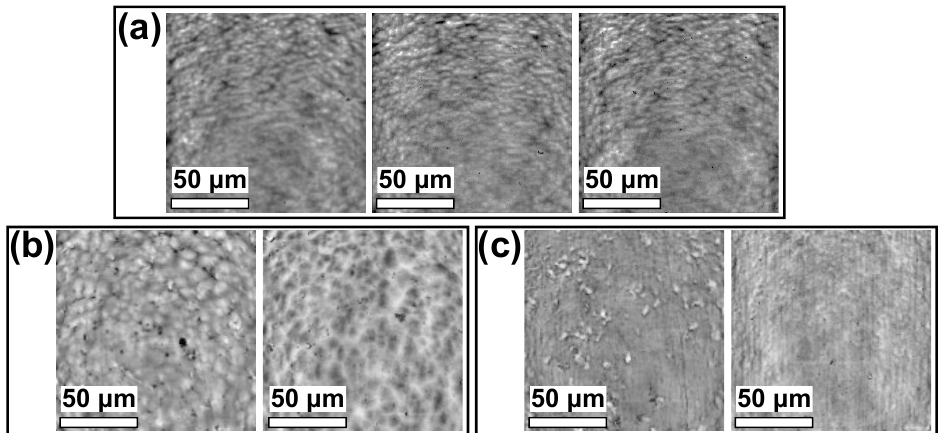
Figure 6. Confocal microscope images for 100 × magnification. From left to right: ( a ) reference and plasma-treated and water-washed PP (ArN- s ); ( b ) PP and epoxy adhesive surface treated at the higher treatment speed (ArN- fo ) after the tensile strength test and ( c ) PP and epoxy adhesive surface treated at the lower treatment speed (Ar- s ) after the tensile strength test.